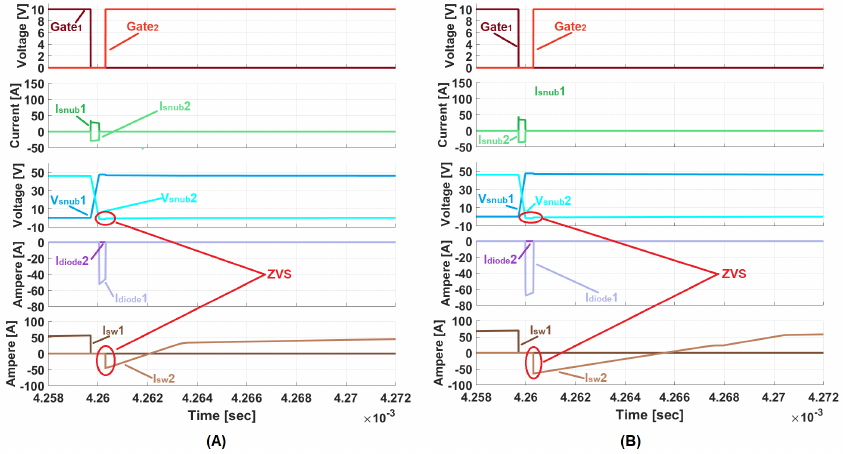
Figure 15. Switching phase of first leg in ZVS conditions when the switch S 1 is opening and S 2 is closing using the algorithm SPS ( A ) and (TPS) ( B ).